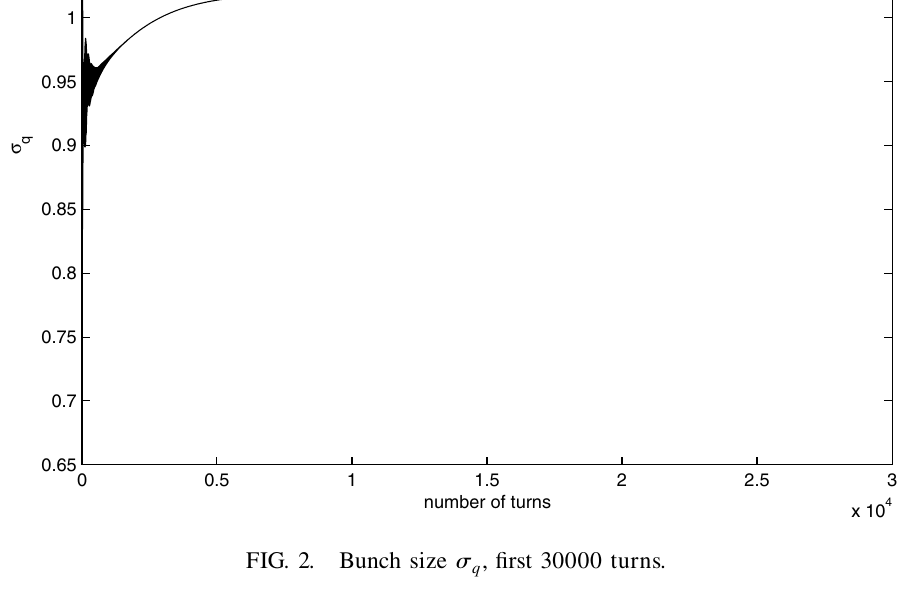
FIG. 2. Bunch size !